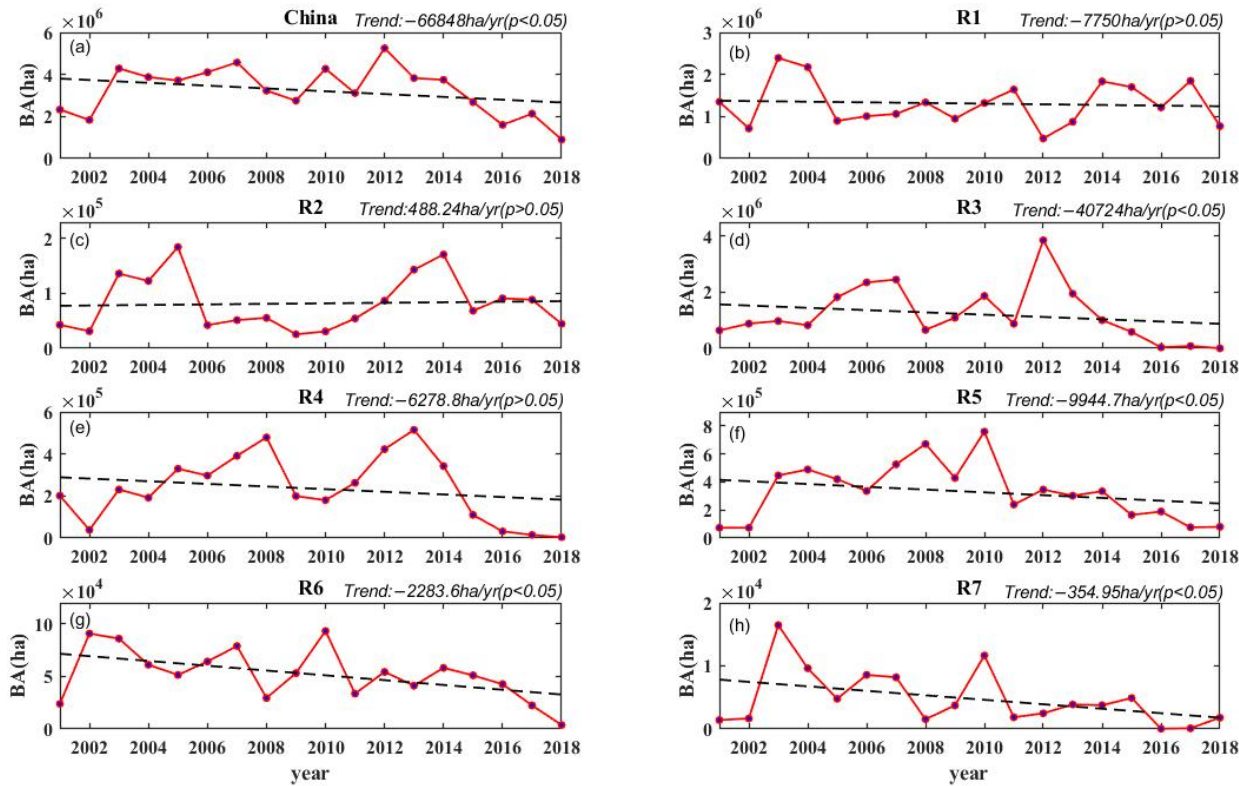
Figure 4. The trends of the annual BA in China and its seven subregions (R1–R7).